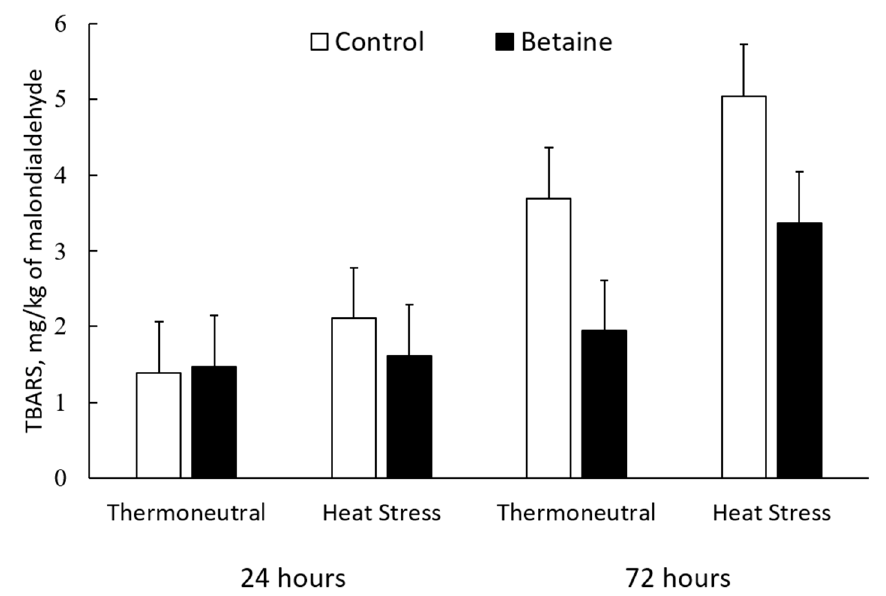
Figure 2. Effect of heat stress, dietary betaine, and time post-slaughter on breast muscle thiobarbituric acid reactive substances (TBARS) in mg/kg of malondialdehyde . Data are mean and standard error of the difference for the interaction between environmental temperature (T), diet (D) and time post-slaughter (TM). There were main effects ( p < 0.10) of T ( p = 0.017), TM ( p < 0.001) and D ( p = 0.008) and an interactive of TM × D ( p = 0.036). There were no other main or interactive effects ( p < 0.10).